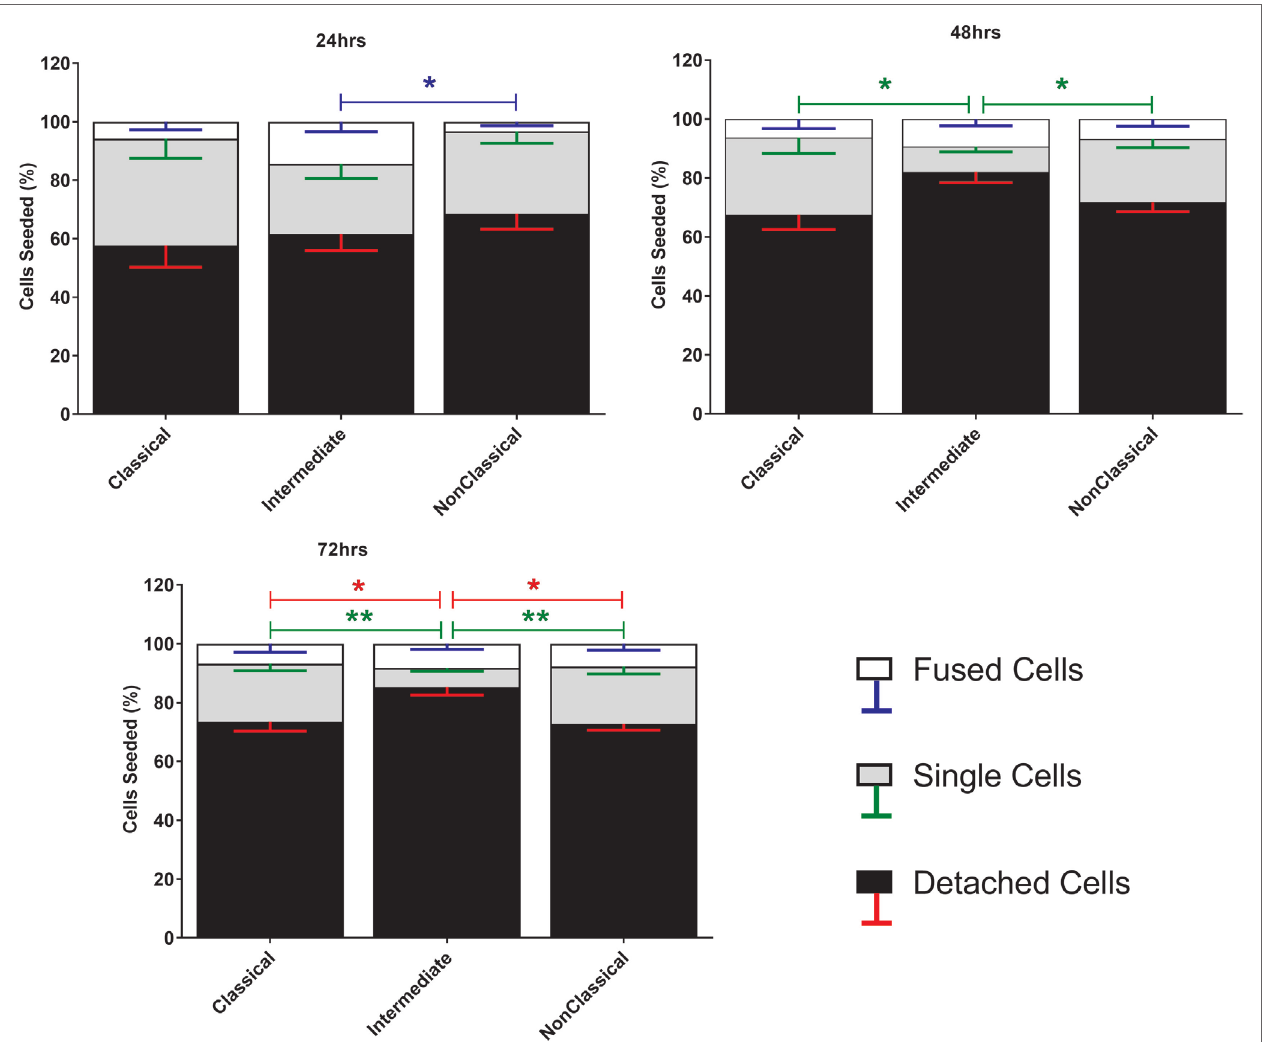
FigUre 1 | Cell fate during ConA­induced fusion varies between monocyte subsets. The fate of sorted monocyte subsets was determined by counting nuclei at 24, 48, and 72 h and expressed as a percentage of the cell numbers originally plated. Bars represent means ± SEM, n = 8. Significance was tested with a Kruskal– Wallis test with a Dunn’s multiple comparisons test comparing the means of the same fate and time point against the other subsets. Black bars/red error bars: detached cells, gray bars/green error bars: single cells and white bars/blue error bars: fused cells with > 3